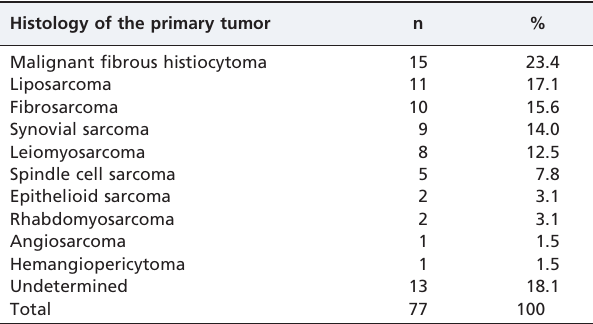
Table 1 - Histologic type in 64 patients submitted to pulmonary metastasectomy.